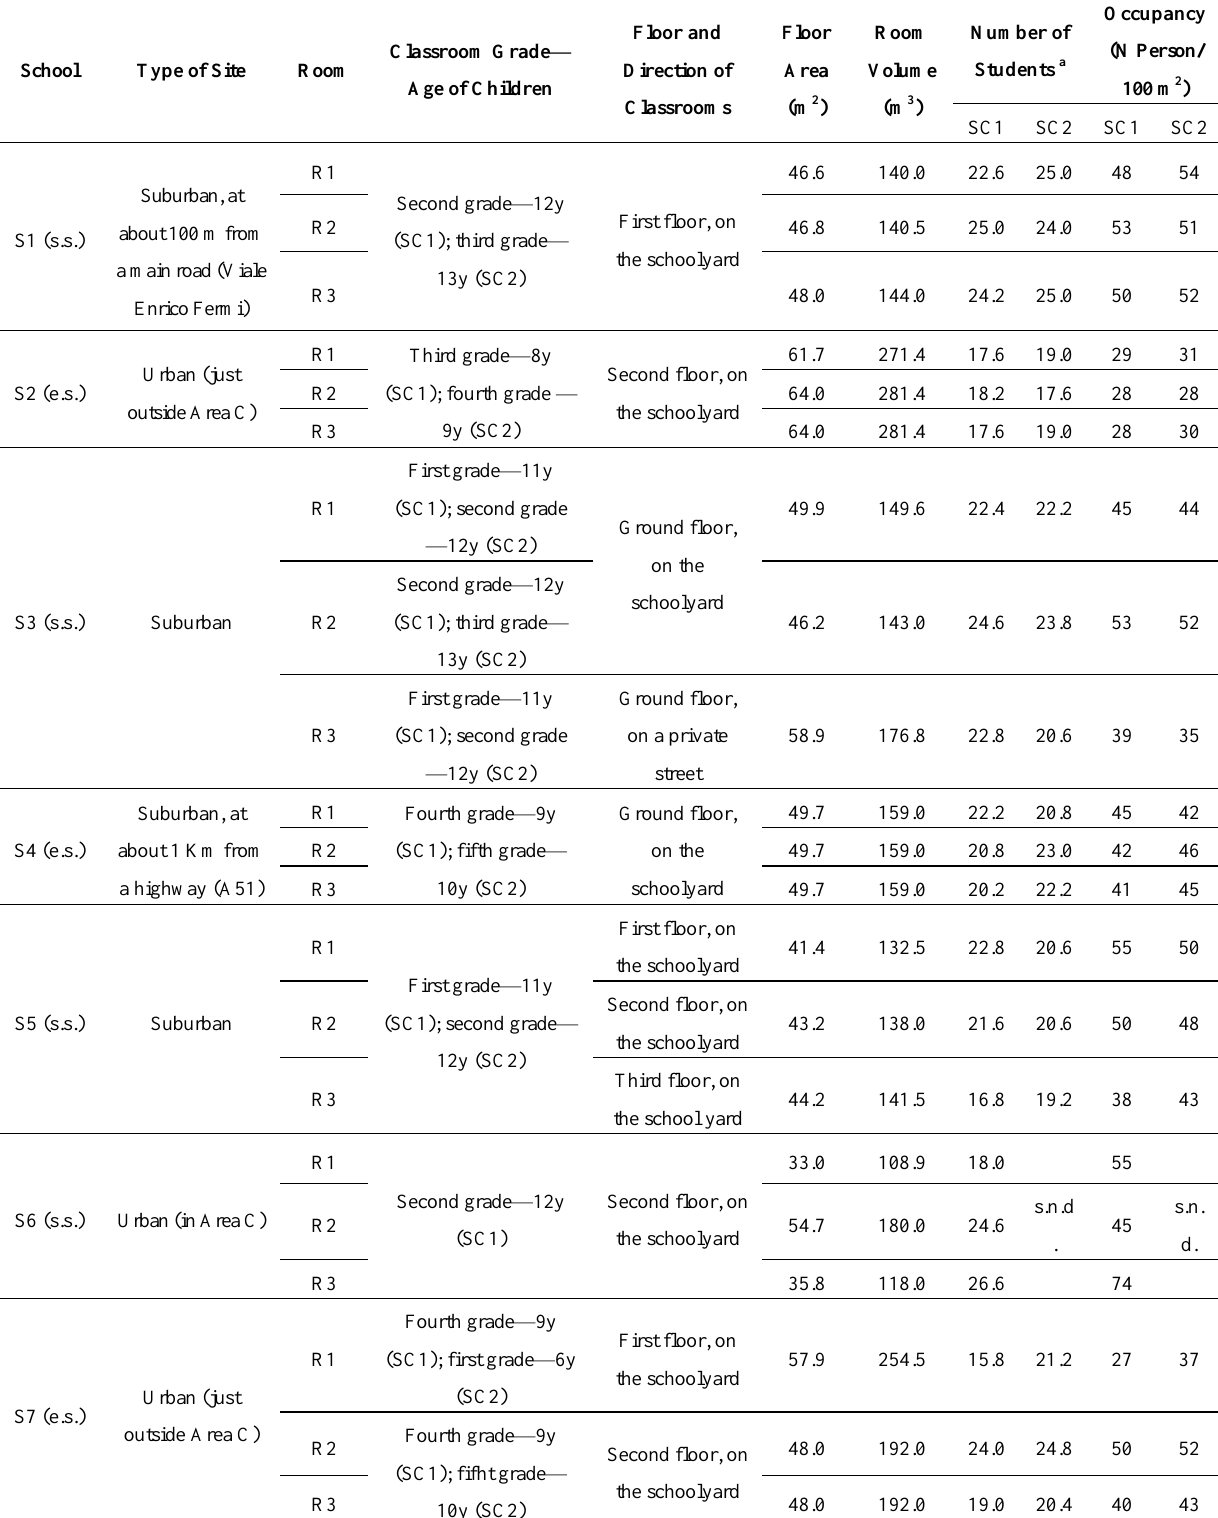
Table 1. Specific school and room characteristics, number of occupants and average occupancy of classrooms; e.s. = elementary school, s.s. = secondary school, s.n.d. = sampling not